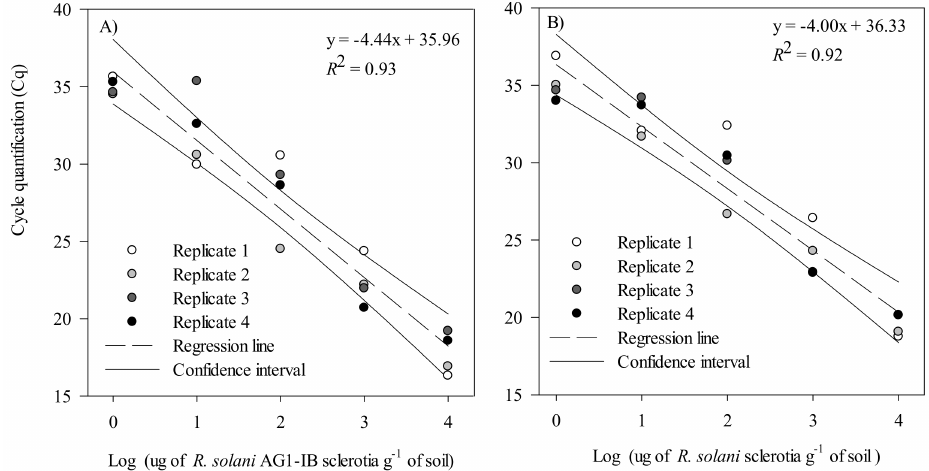
Figure 4. Linear regression of the mean cycle threshold (Cq) value plotted against the log10 of sclerotia ( µ g sclerotia g − 1 of dry soil) of ( A ) Rhizoctonia solani AG1-IB and ( B ) R. solani , obtained from the artificial inoculation of sterilized muck soils. These experiments were conducted using four biological replicates and two technical replicates for each biological replicate. Cq values for these experiments are provided in Supplementary Table S5.